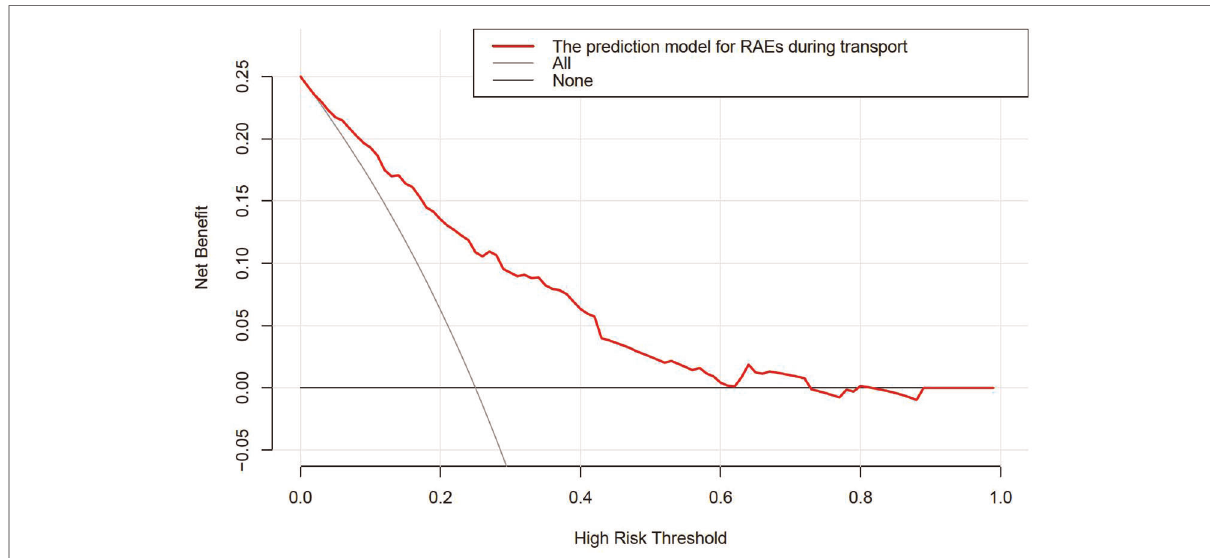
FIGURE 5 The DCA shows the clinical usefulness of the nomogram. The Y -axis represents net bene fi t. The solid red line is a nomogram predicting the risk of RAEs during transport. The solid gray line indicates that all patients occurred RAEs during transport, while the fi ne solid black line indicates that no patient occurred RAEs during transport. This DCA could provide a larger net bene fi t, with ranges of 0% – 74%. DCA, decision curve analysis; RAEs, respiratory adverse